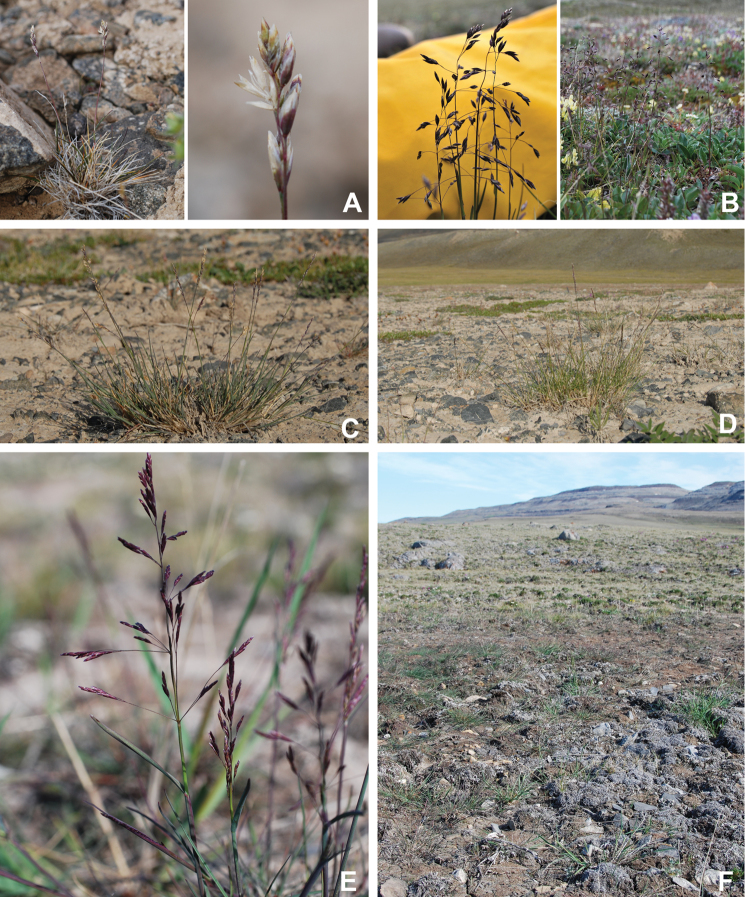
APoa
abbreviata
subsp.
abbreviata habit (left) and inflorescence (right), Gillespie et al. 9865BPoa
arctica
subsp.
arctica inflorescence (left) and habit (right) CPoa
glauca
subsp.
glauca habit, Gillespie et al. 10079DPoa
hartzii
subsp.
hartzii habit, Gillespie et al. 10078EPuccinellia
arctica inflorescence, Gillespie et al. 9660FPuccinellia
arctica habitat, Gillespie et al. 9660. Photos A, E, F by J.M. Saarela B by B.A. Bennett and C, D by L.J. Gillespie.